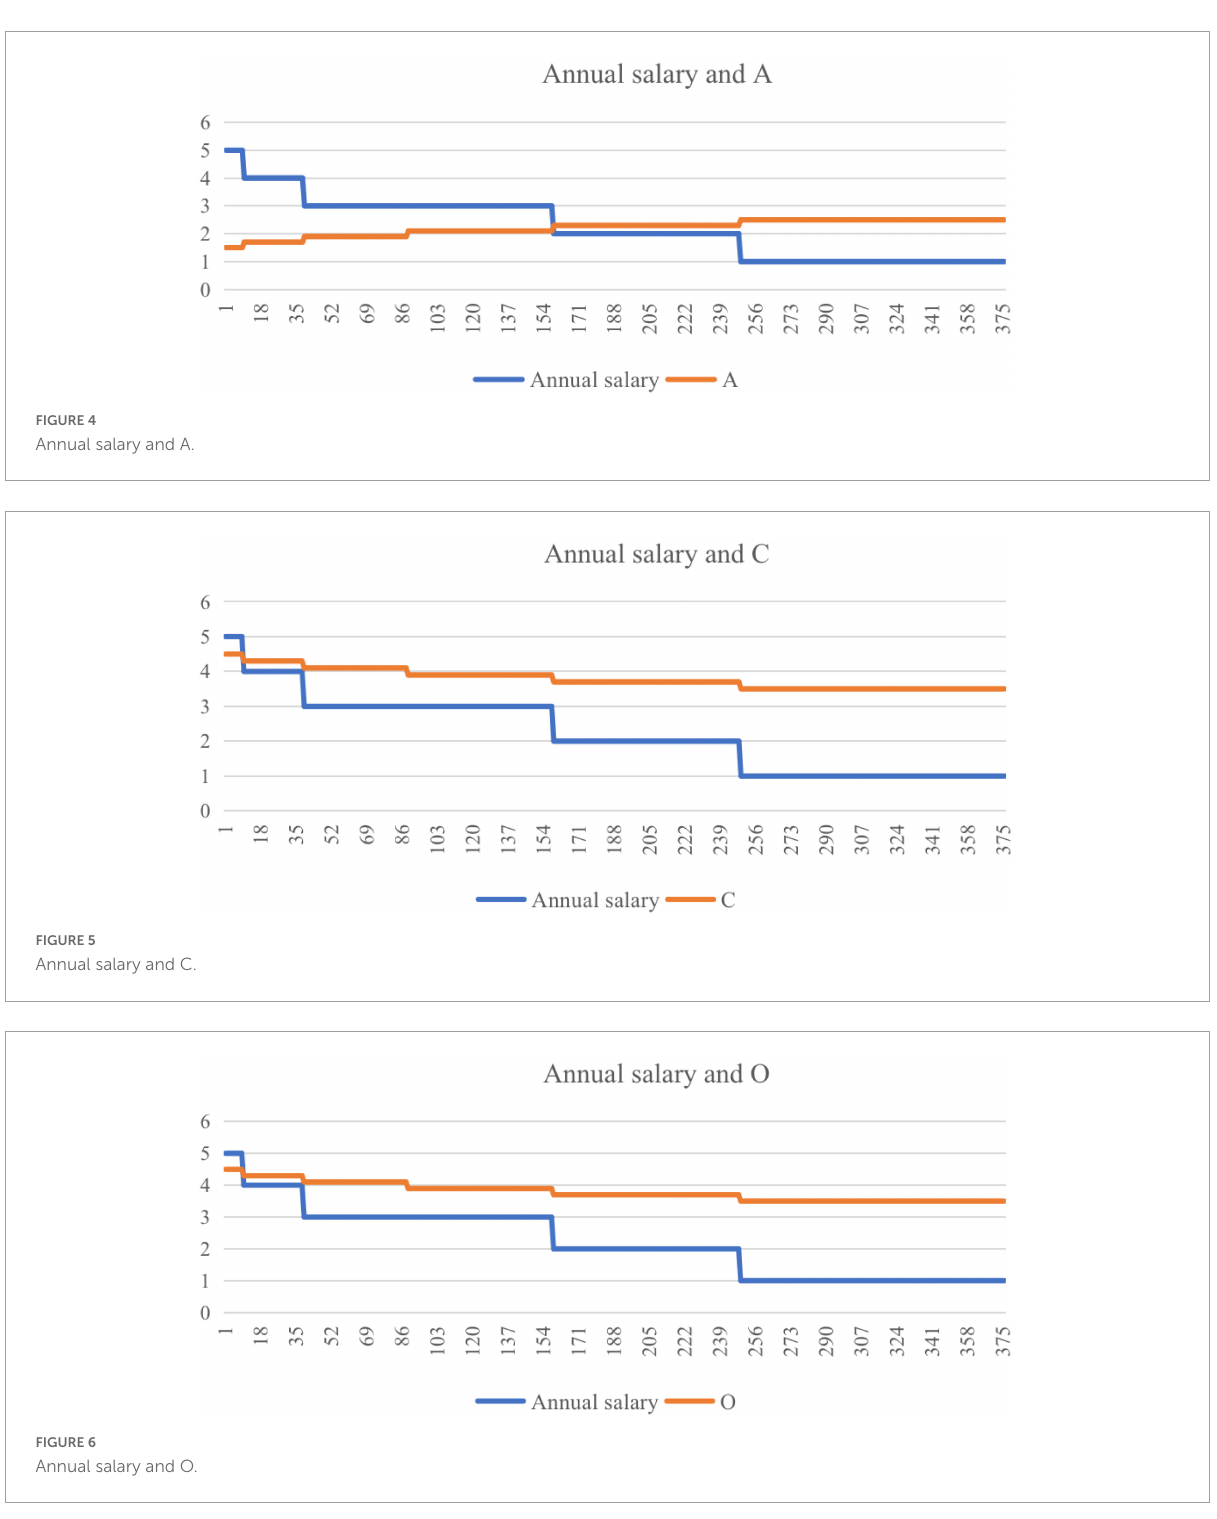
FIGURE6 Annual salary and